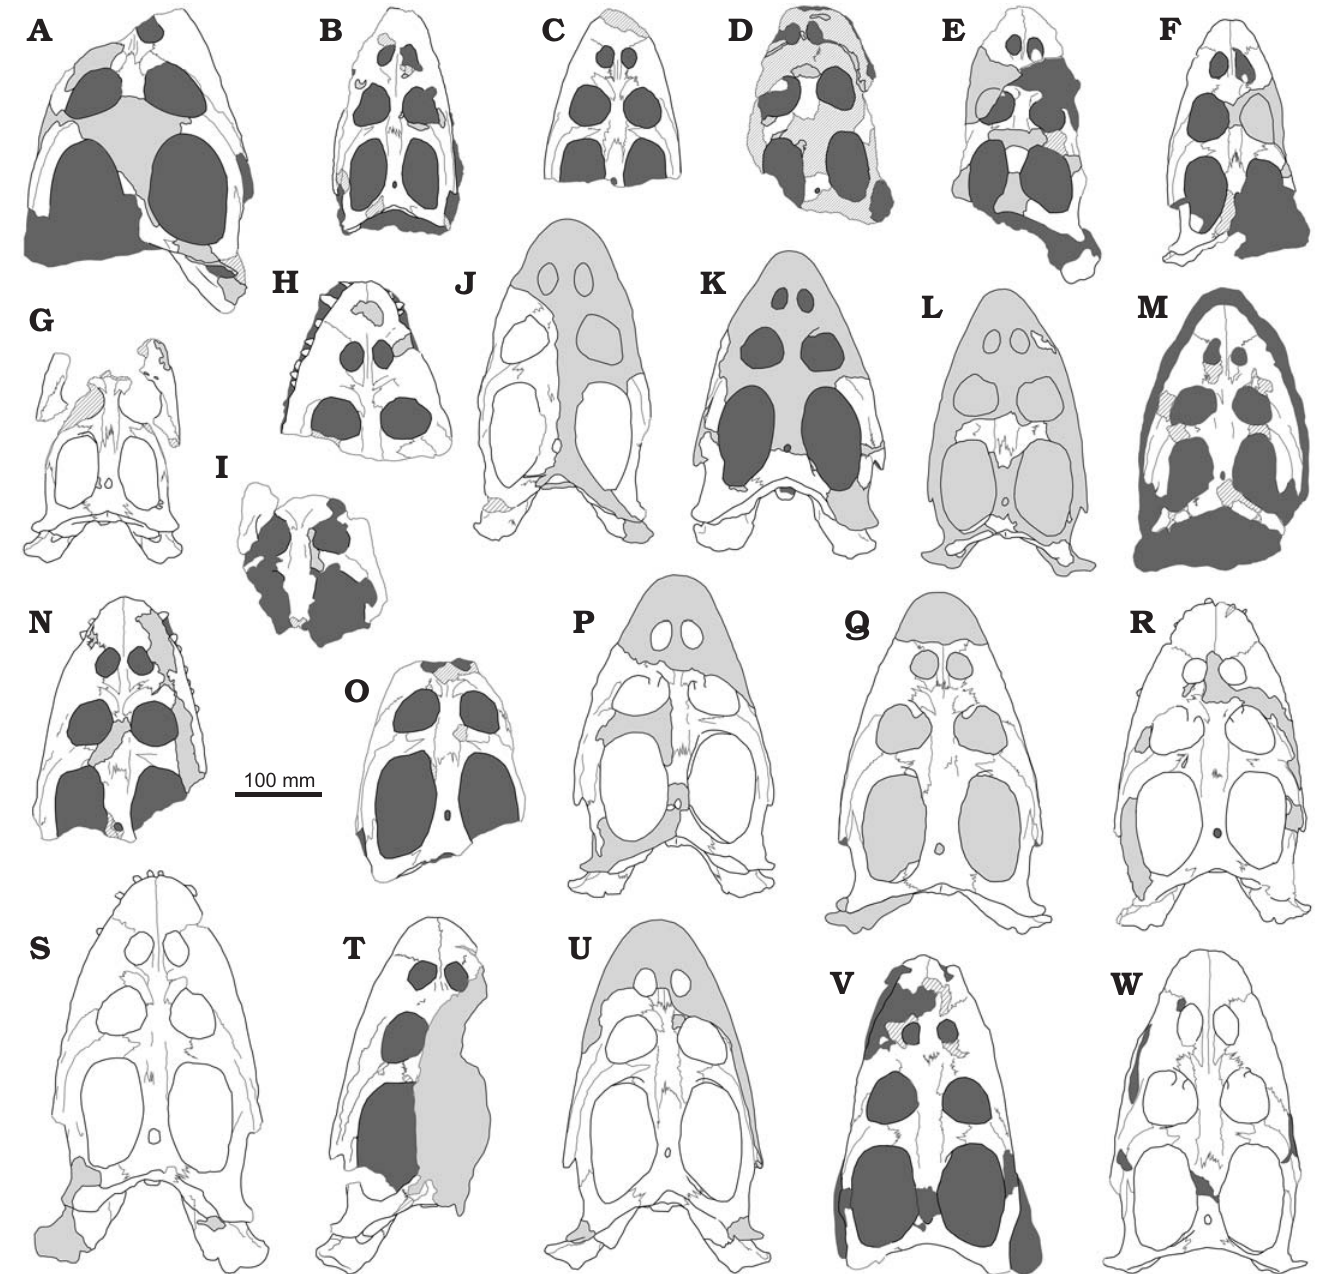
Fig. 2. Schematic interpretations of the skulls of simosaurid sauropterygian Simosaurus gaillardoti Meyer, 1842 from the Ladinian, Middle Triassic of northeastern France (B, D) and southwestern Germany (A, C, E–W), in dorsal view. A . MB.R. 52. B . MNHN.F.AC. 9028 (neotype of Simosaurus gaillar- doti ). C . SMNS 18520. D . MNHN.F.AC. 9025. E . SMNS 16639. F . SMNS 18274. G . SMNS 16767. H . SMSN 18220. I . SMNS 16735a. J . MHI 1366. K . SMNS 59366. L . SMNS 56288. M . SMNS 16700 (holotype of “ Simosaurus guilielmi ” Meyer, 1852). N . SMNS 18550. O . SMNS 11364. P . SMNS 50714. Q . SMNS 16363. R . GPIT/RE/09313. S . MHI 1833. T . SMNS 18637. U . SMNS 50715. V . SMNS 59943. W . SMNS 10360. Light grey, plaster; dark grey, matrix; grated areas, broken or altered bones; dashed lines, limits of broken bones; thin grey lines,